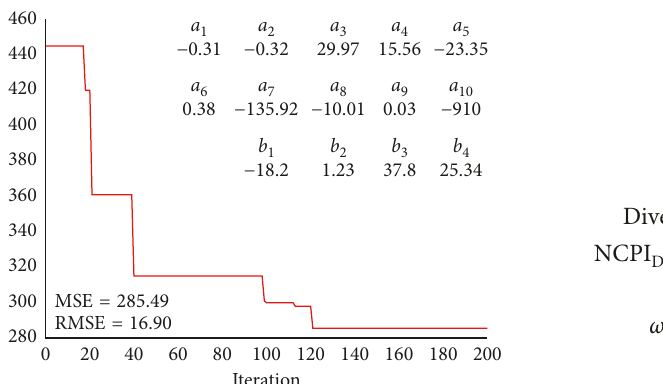
Figure 13: PSO iteration in the diverge area (best cost